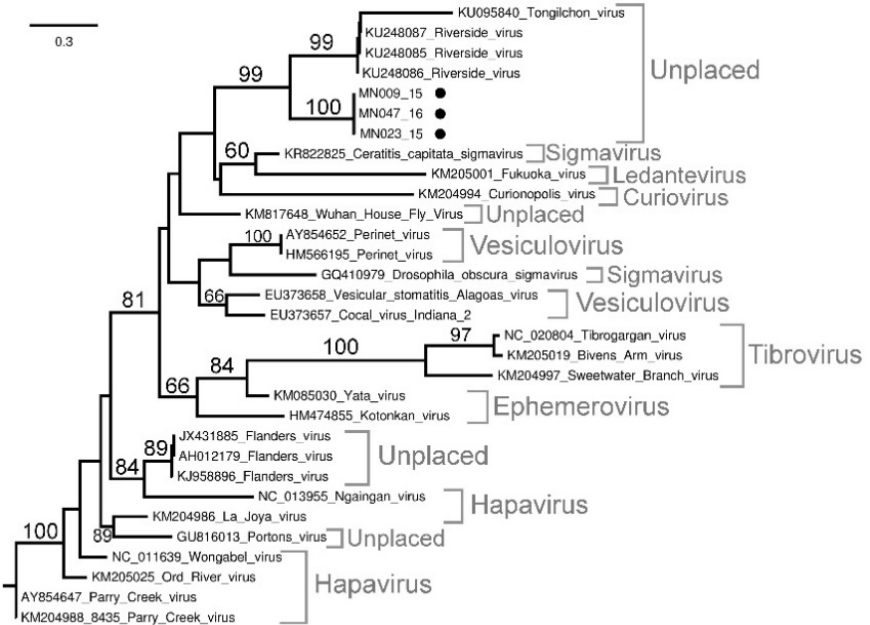
Figure 5. Maximum likelihood phylogram based on the partial (nucleotides = 310, 31 taxa) L segment of Rhabdoviridae viruses. Bootstrap support calculated using autoMRE function invoked in RAxML (GTR + G model). Filled black circles indicate new sequences.